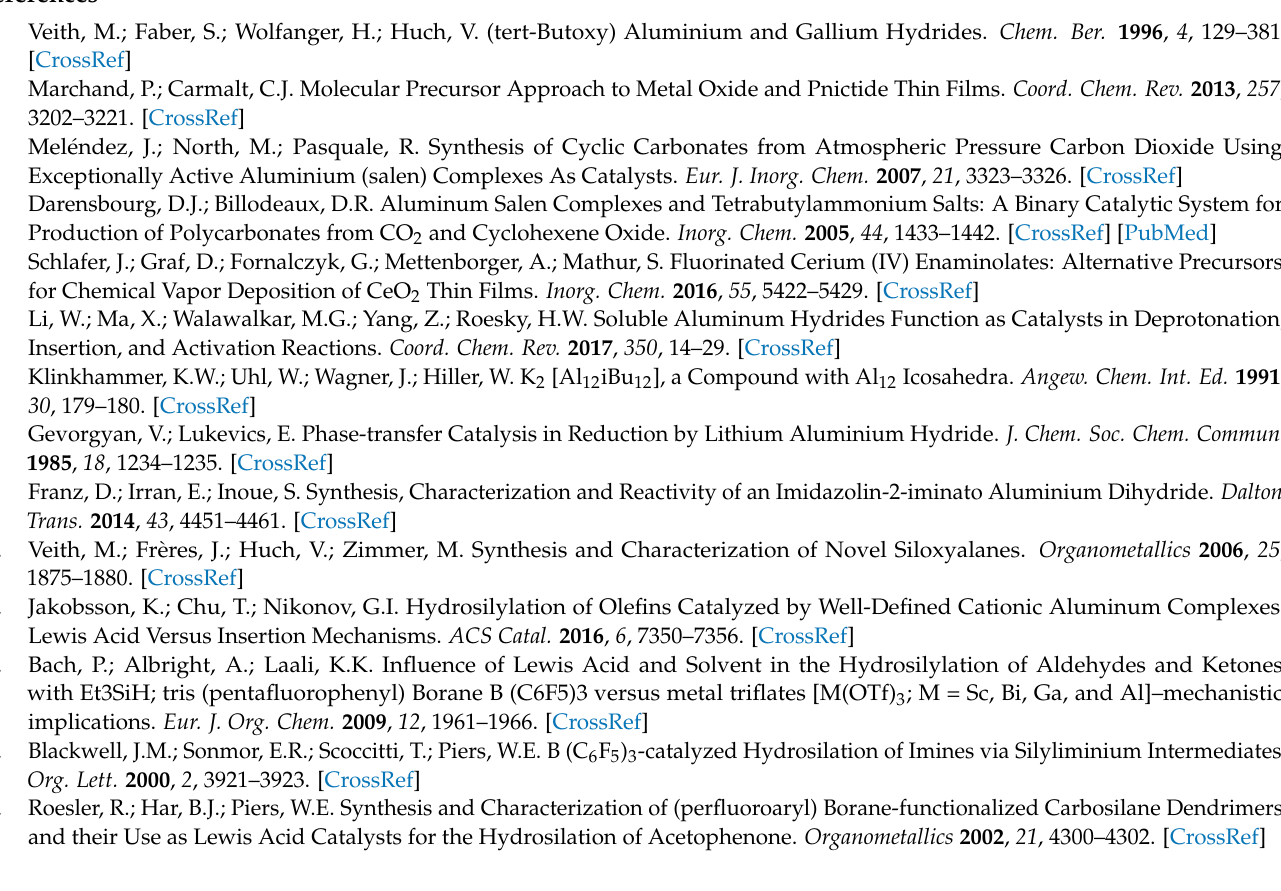
multiple bond correlation (HMBC) spectra of 4b and 4b (cid:48) at room temperature, Figure S10: 1 H − 13 C Heteronuclear multiple quantum coherence (HMQC) spectra of 4b and 4b (cid:48) at room temperature, Figure S11: Solution 27 Al NMR spectra of complexes 3 recorded in C 6 D 6 at room temperature, Figure S12: Solution 27 Al NMR spectra of complexes 4b and 4b (cid:48) recorded in C 6 D 6 at room temperature, Figure S13: FT-IR spectra of the enaminone ligand (black), compound 3 (red) and compound ( 4 ) (blue), Figure S14: Obtained XRD pattern of the residue of 3 and 4a after TG, Figure S15: Representative SEM images of post-annealed thin films deposited using 4 as precursor in a CVD